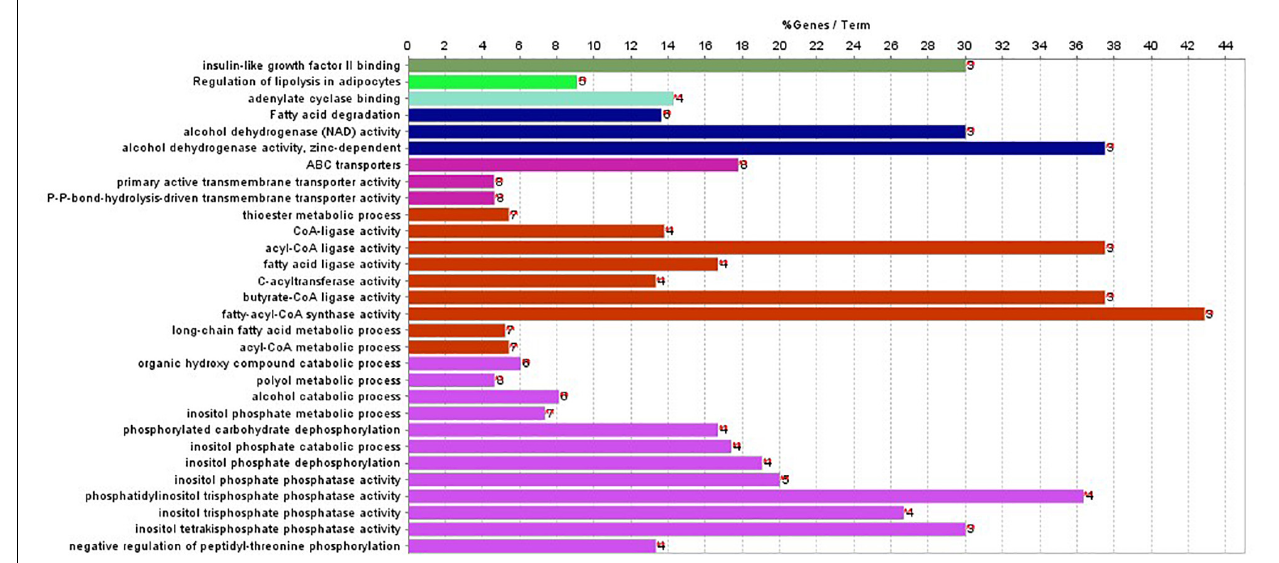
FIGURE 4 | Gene enriched in biological process, cellular component, and molecular function were drawn for first 100-gene set by ClueGO.